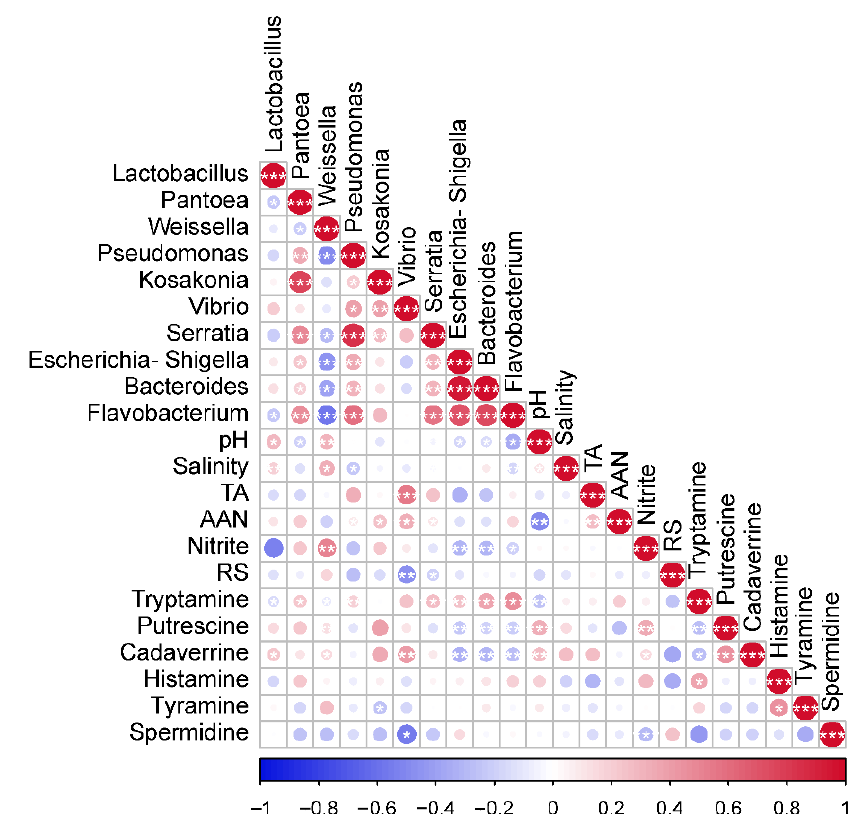
Figure 4. Spearman rank correlation analysis to study the physicochemical factors and dominant genus in Chinese fermented vegetable. The Spearman correlation coefficient r ranges from − 0.5 to 0.5, r < 0 is a negative correlation, r > 0 is a positive correlation. * p < 0.05, ** p < 0.01, *** p < 0.001.